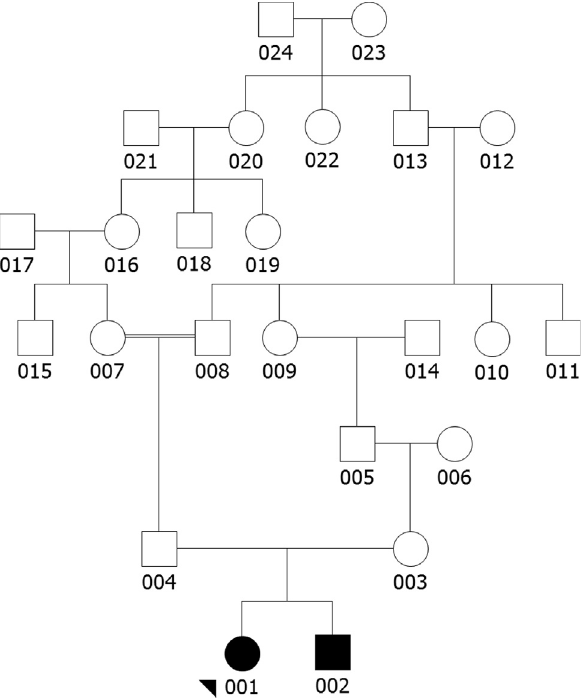
Figure 1 - Graphical pedigree of the tabulated genealogy shown in Table